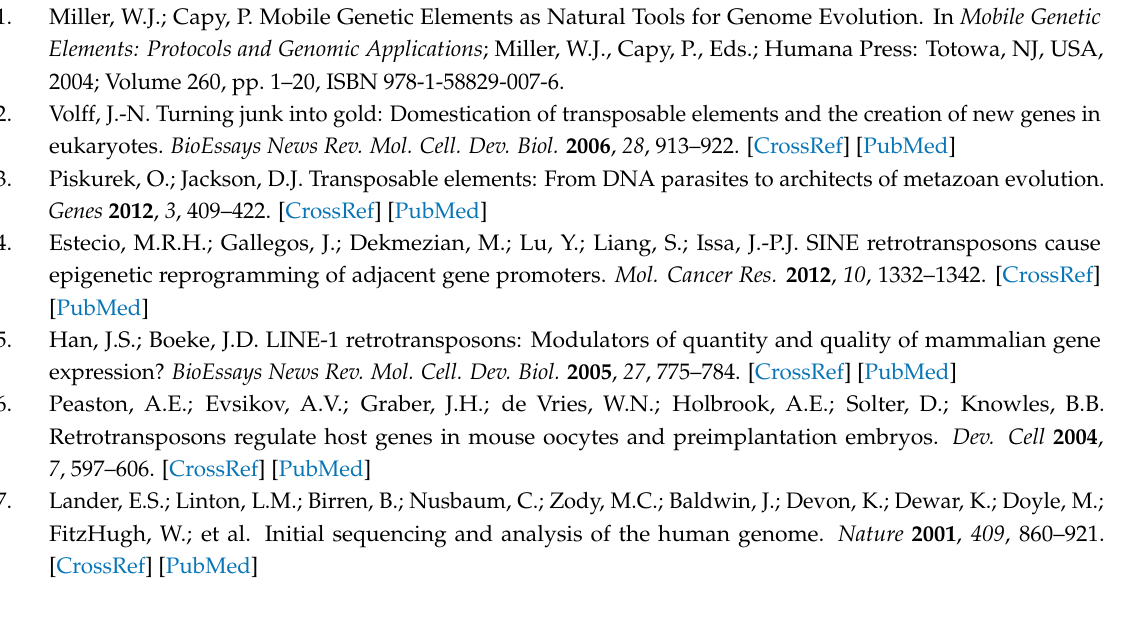
Table S3: Sequences of Alu duplex 1 bands of sample DO 3756, Table S4: STR